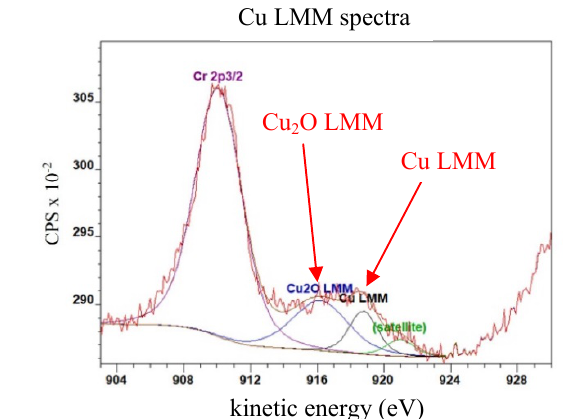
Figure 10. LMM Auger spectrum of the disc specimen tested with 0.5 wt% CuO lubricant sample